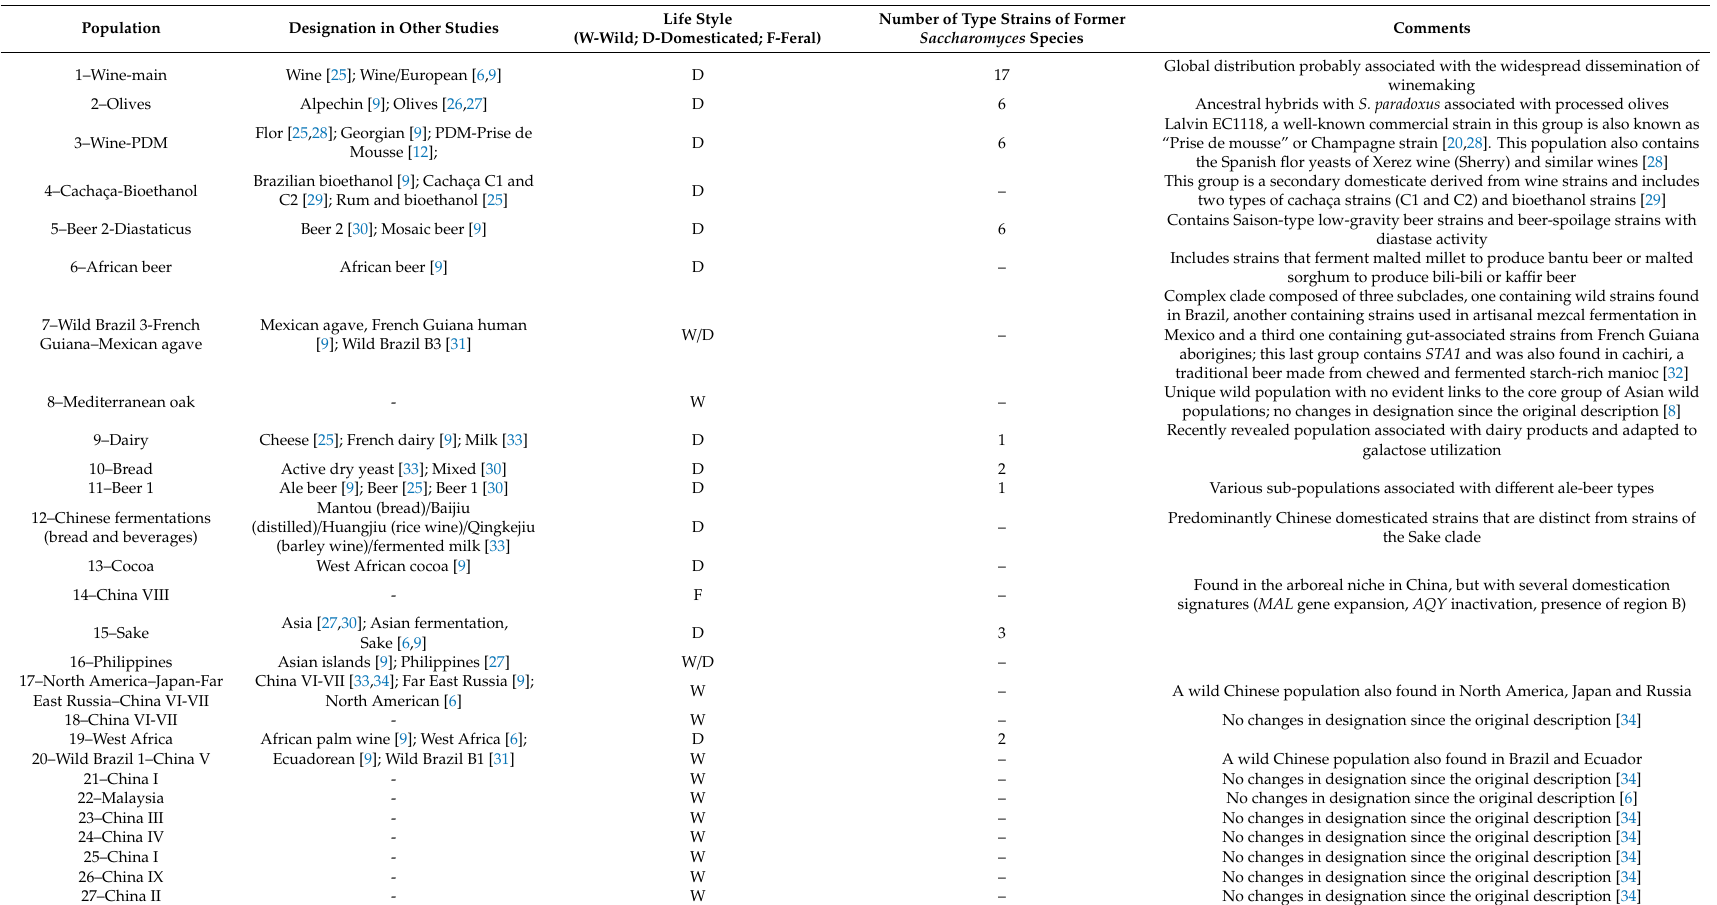
Table 2. Populations of S. cerevisiae and their